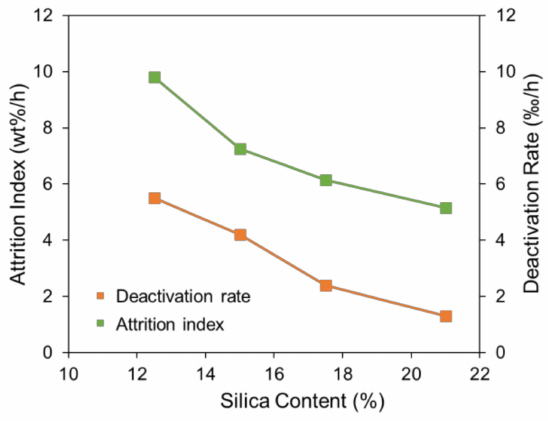
Figure 1. Correlation between the silica content and the attrition index and stability. Table 2. Fischer–Tropsch synthesis performances of the prepared catalysts 1 .